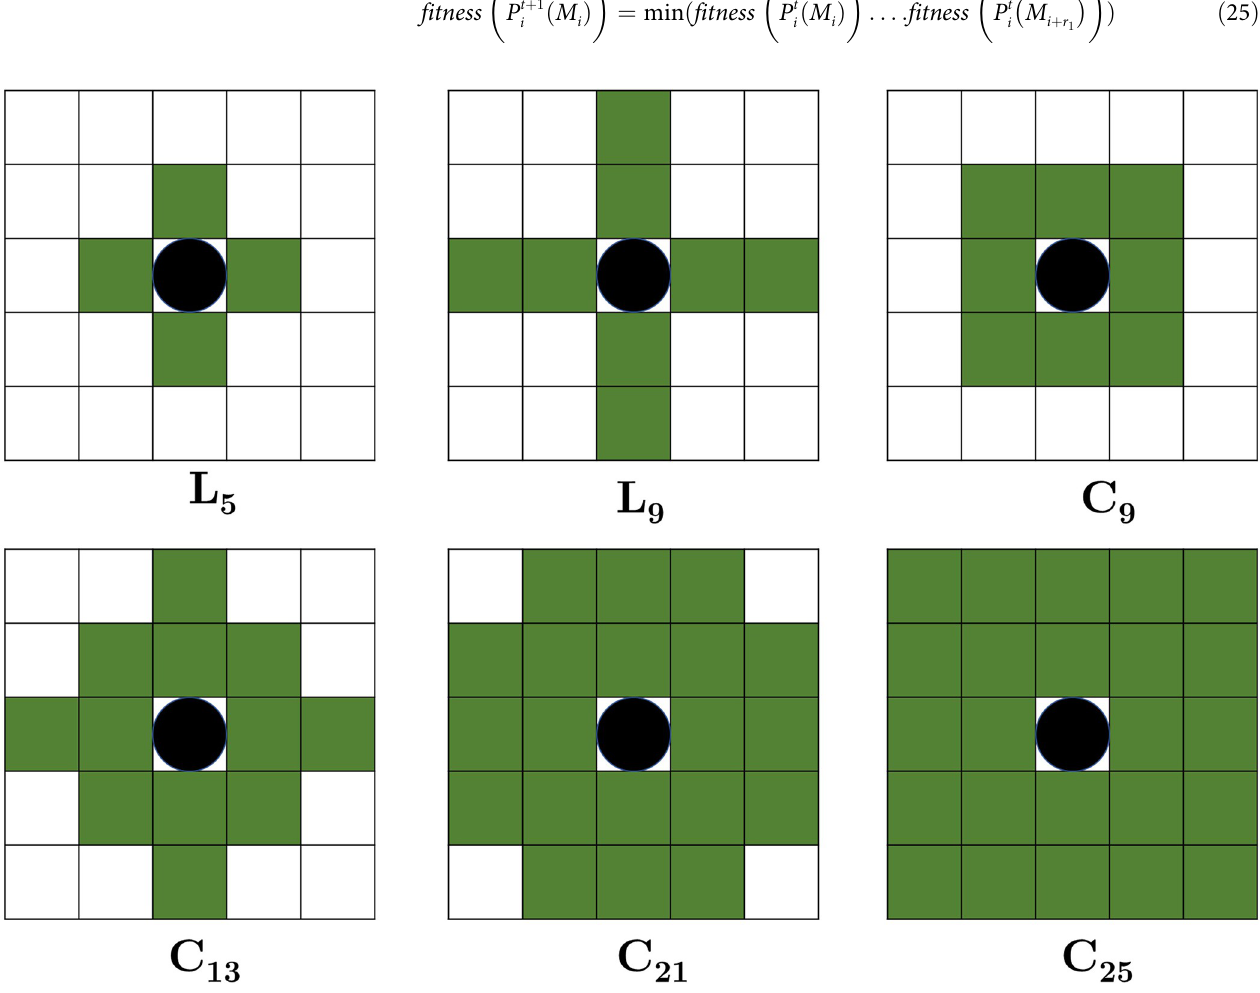
Fig 3. Different types of neighbourhood